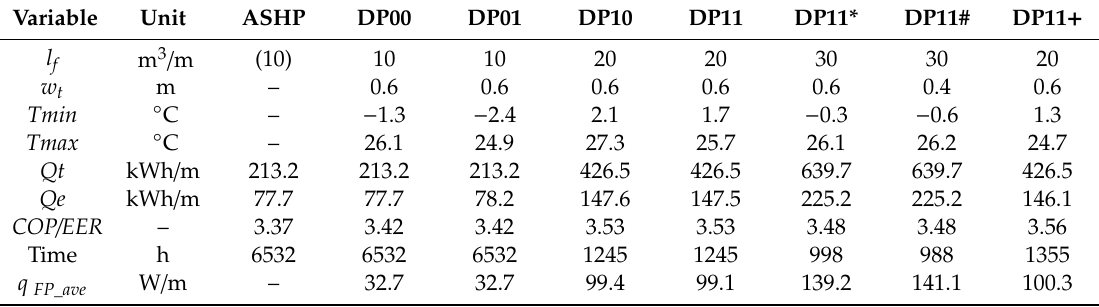
Table 5. Annual energy performance for the di ff erent case studies. Minimum and maximum GHE temperatures are also